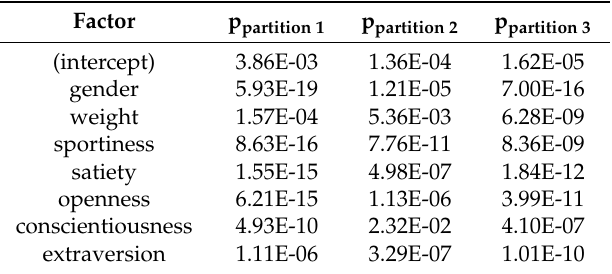
Table 6. Unsupervised learning: MANOVA, participant